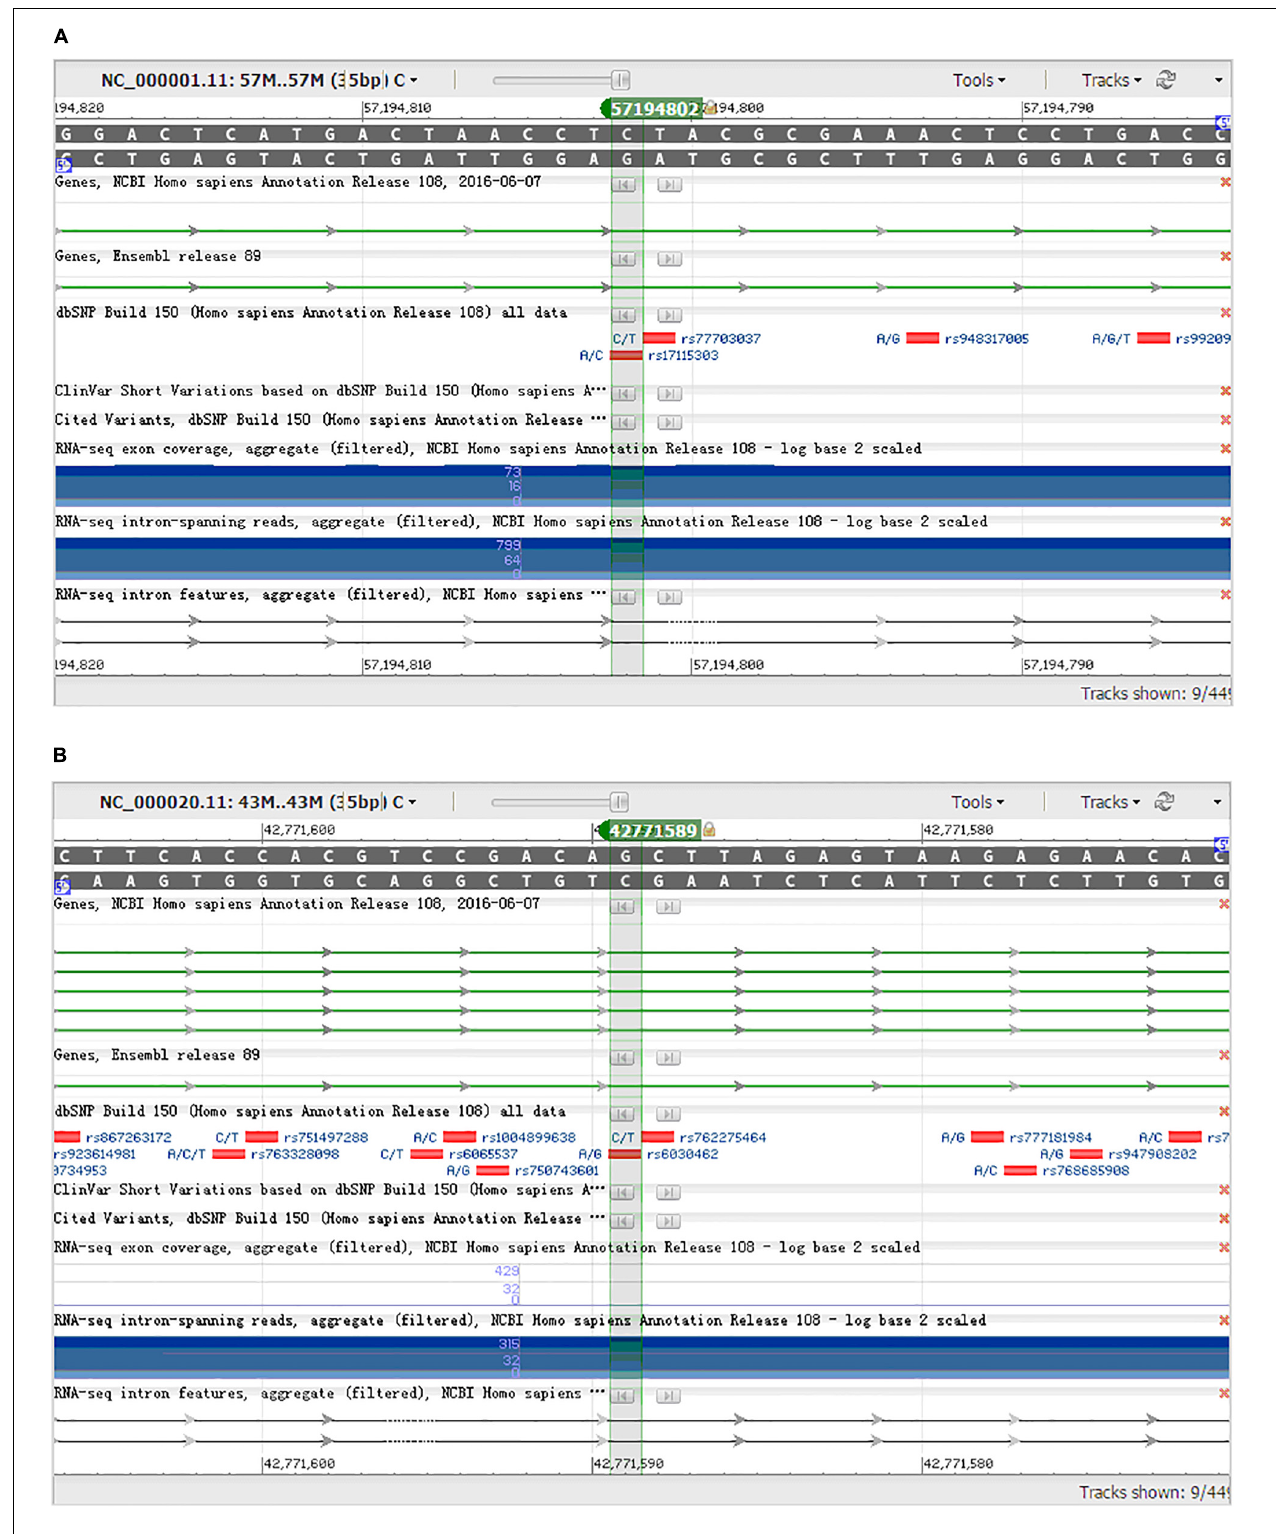
FIGURE 4 | NCBI gene sequence positions of DAB1 rs17115303 and PTPRT rs6030462. (A) DAB1 gene located at chr1:57194802 with a C-to-A transversion on the reverse strand. (B) PTPRT gene located at chr20:42771589 with a G-to-A transition on the reverse strand. NCBI, National Center for Biotechnology Information.